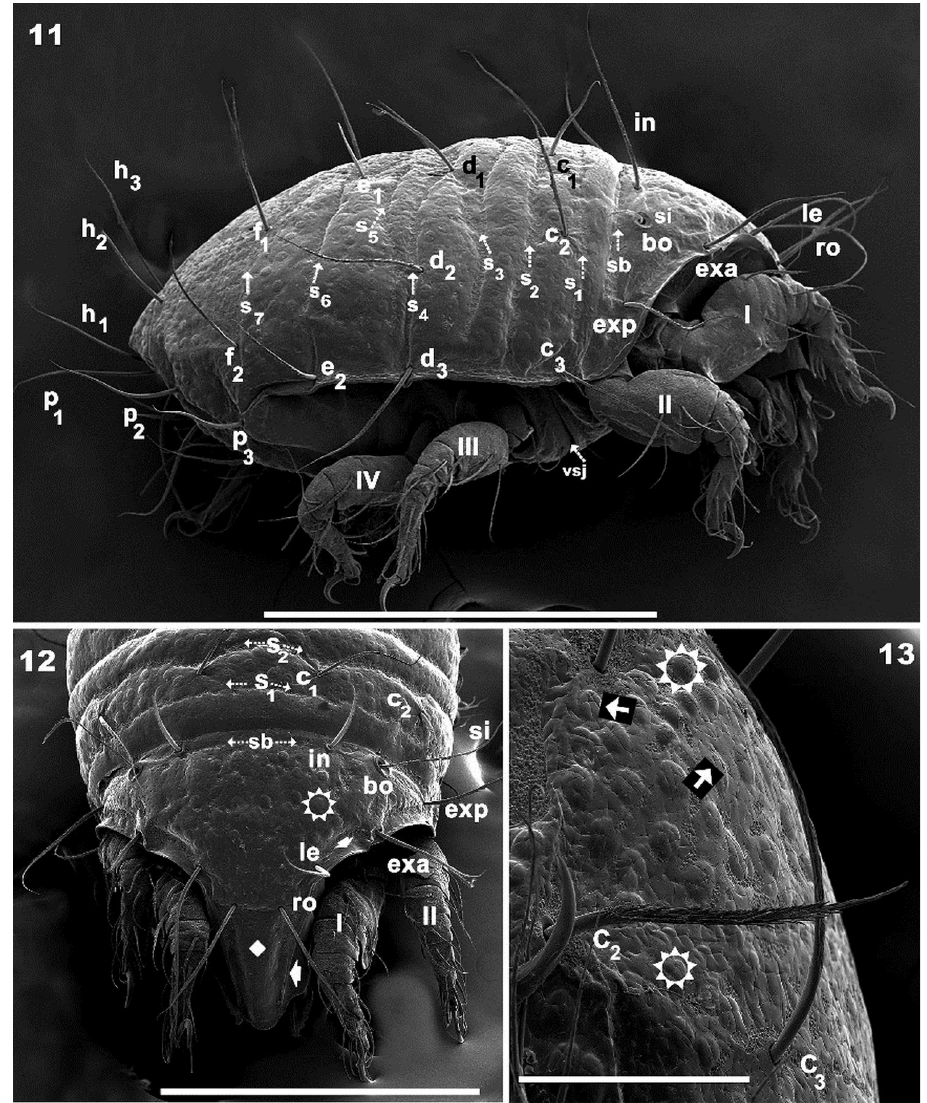
Figures 11–13. Meristacarus perikopesis sp. n. Adult with cerotegumental layer. SEM micrographs. 11 lateral view 12 frontal view 13 notogastral anterior lateral view. Scale bars: 500 μm ( 11 ); 400 μm ( 12 ); 100 μm ( 13